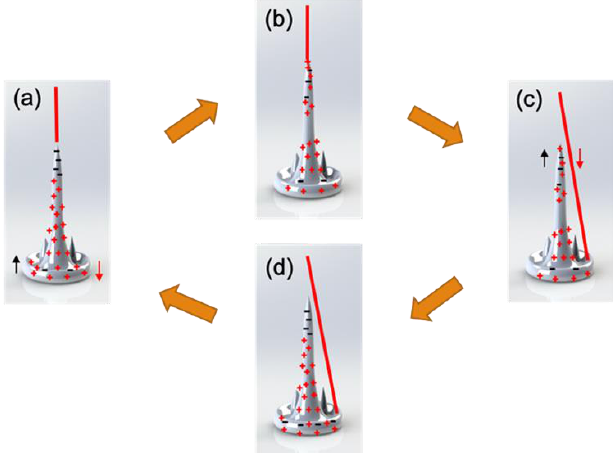
Figure 8. Cyclic change of jet state and deposit polarization state in steady-state printing phase: ( a ) the jet is attracted back from the outer ring to central cone, wherein the central cone is sufficiently polarized; ( b ) the jet is deposited on the cone, wherein the central cone becomes gradually positively charged; ( c ) the jet is repelled away from the central cone to the outer ring, wherein the outer ring is sufficiently polarized; ( d ) the jet is deposited on the outer ring, wherein the outer ring becomes gradually positively charged.